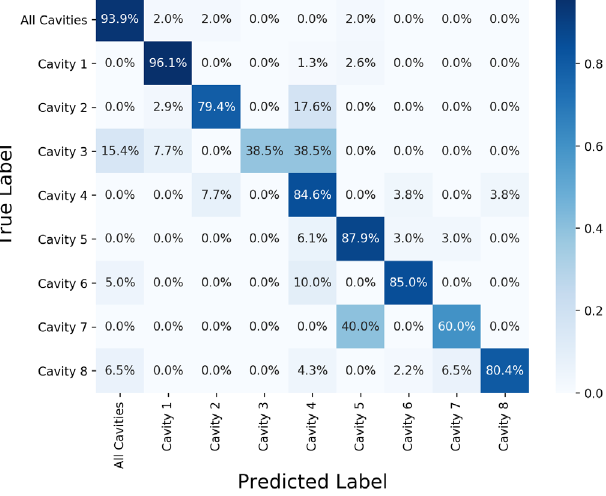
FIG. 9. Confusion matrix showing performance of the deployed cavity identification model on 312 fault events compared to the labels provided by a subject matter